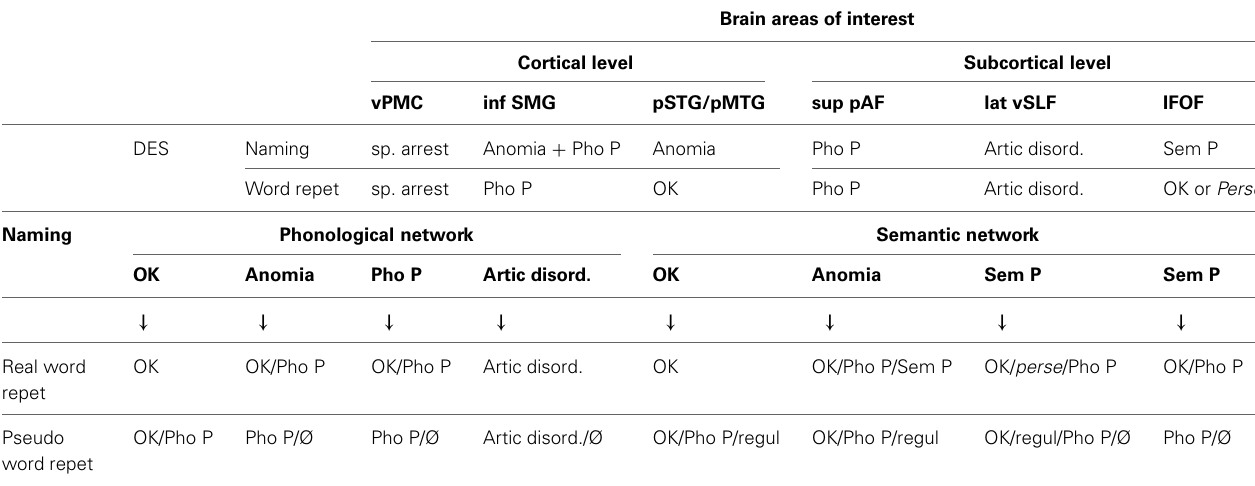
Table 1 | Neural bases of word